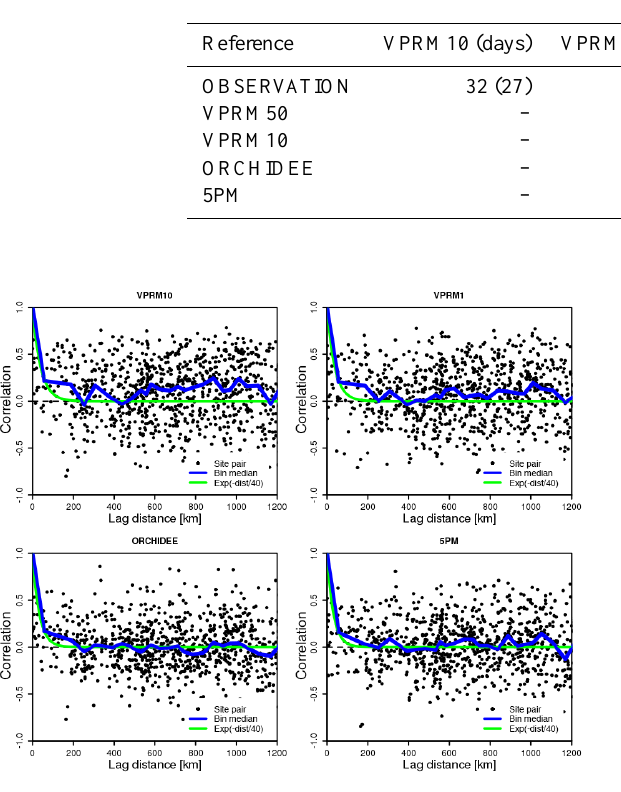
Figure 6. Distance correlogram for the daily net ecosystem ex- change (NEE) residuals using all sites. Black dots represent the dif- ferent site pairs; the blue line represents the median value of the points per 100km bin and the green an exponential fit. Results are shown for residuals of VPRM at a resolution of 10 (top left) and 1km (top right), ORCHIDEE (bottom left), 5PM (bottom right).